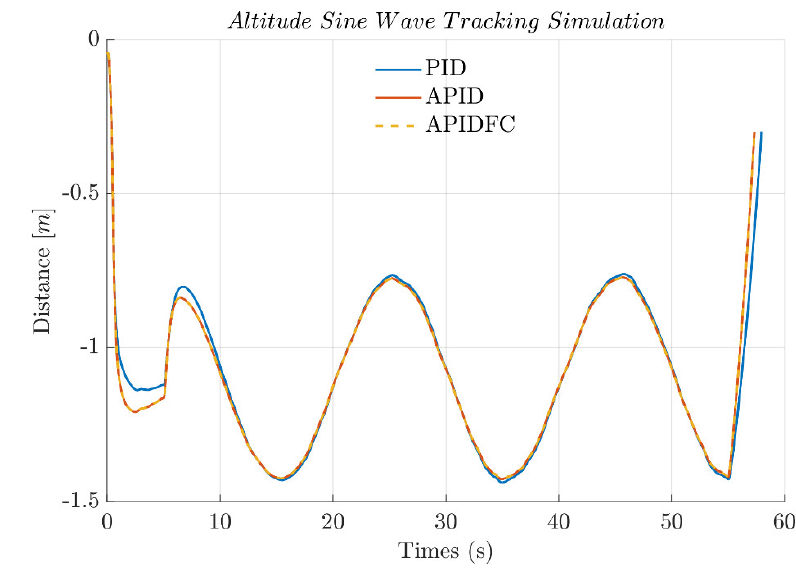
Figure 8. Sine wave tracking in the simulation.